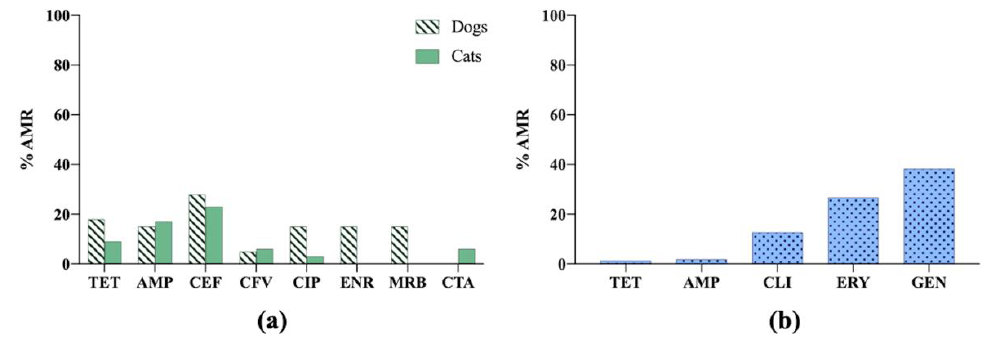
Figure 10. ( a ) Antimicrobial resistance (AMR) prevalence in Escherichia coli isolated from dogs and cats in Switzerland. TET: tetracycline; AMP: ampicillin; CEF: cephalothin; CFV: cefovecin; CIP: ciprofloxacin; ENR: enrofloxacin; MRB: marbofloxacin; CTA: cefotaxime. ( b ) Antimicrobial resistance (AMR) prevalence in Staphylococcus pseudintermedius isolated from dogs in Switzerland. TET: tetracycline; AMP: ampicillin; CLI: clindamycin; ERY: erythromycin; GEN: gentamicin.